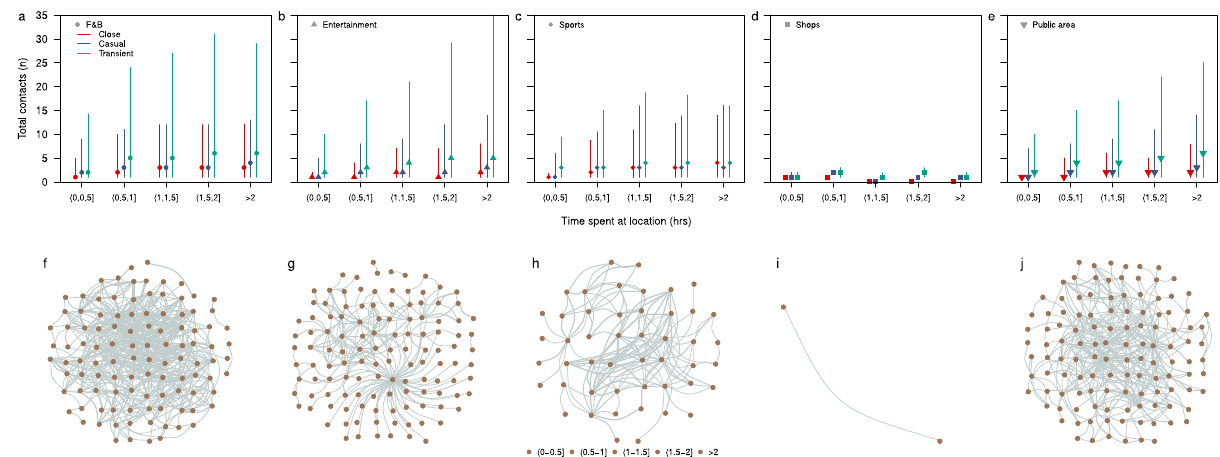
Fig. 2 Number of contacts made over time in respective locations. Contacts made between passengers from different travelling groups per visit to a type of location ( a – e ) and a snapshot of contact network at respective locations for 2 h intervals on the second day of the sailing ( f – j ). Type of locations are: F&B ( a , f ), entertainment ( b , g ), sports ( c , h ), shops ( d , i ) and public areas ( e , j ). Median (shapes), 50% (dark lines) and 95% intervals (light lines) of contacts from 5216 passenger and 4197 crew across four sailings are shown in ( a – e ). Nodes of different colour intensity represent the time spent in the location by respective passengers in ( f – j) .